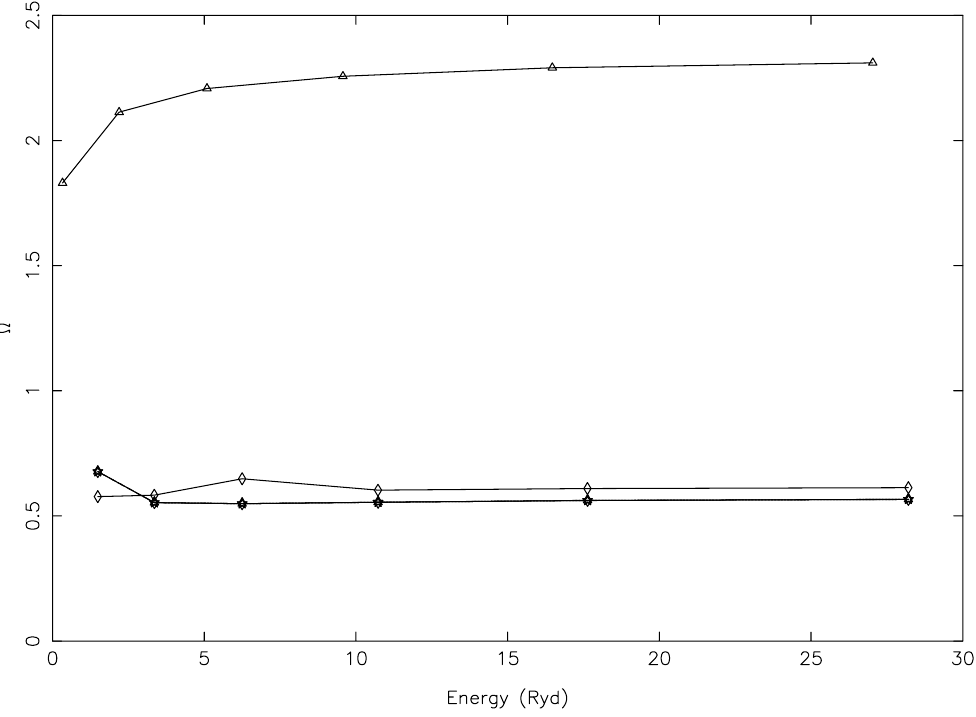
–3p3d 3 D o ) transitions of S 3 1